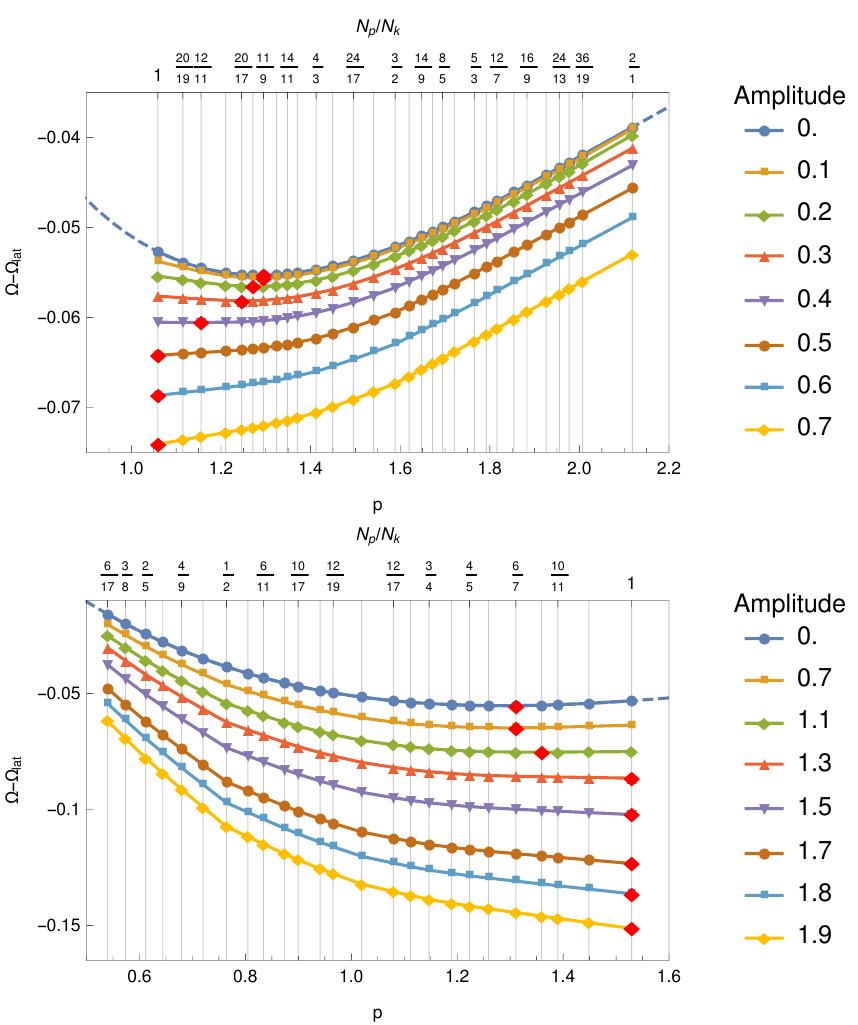
Figure 2 . Thermodynamic potential of di(cid:11)erent incommensurate solutions, measured with respect to the lattice without spontaneous structure at di(cid:11)erent amplitudes of the lattice. For temperature T = 0 : 01 the spontaneous momentum is p 0 ( T ) = 1 : 28. Upper panel shows the case when the lattice momentum is smaller: k = 1 : 06 < p 0 , Lower panel | larger k = 1 : 53 > p 0 . Red diamonds